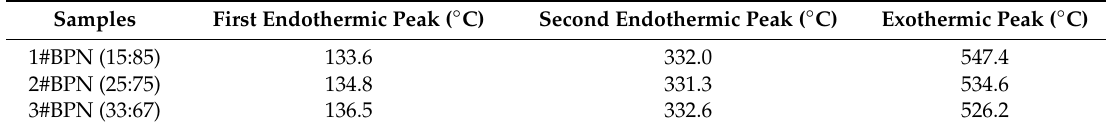
Table 4. Peak temperature of DSC with di ff erent ratios of